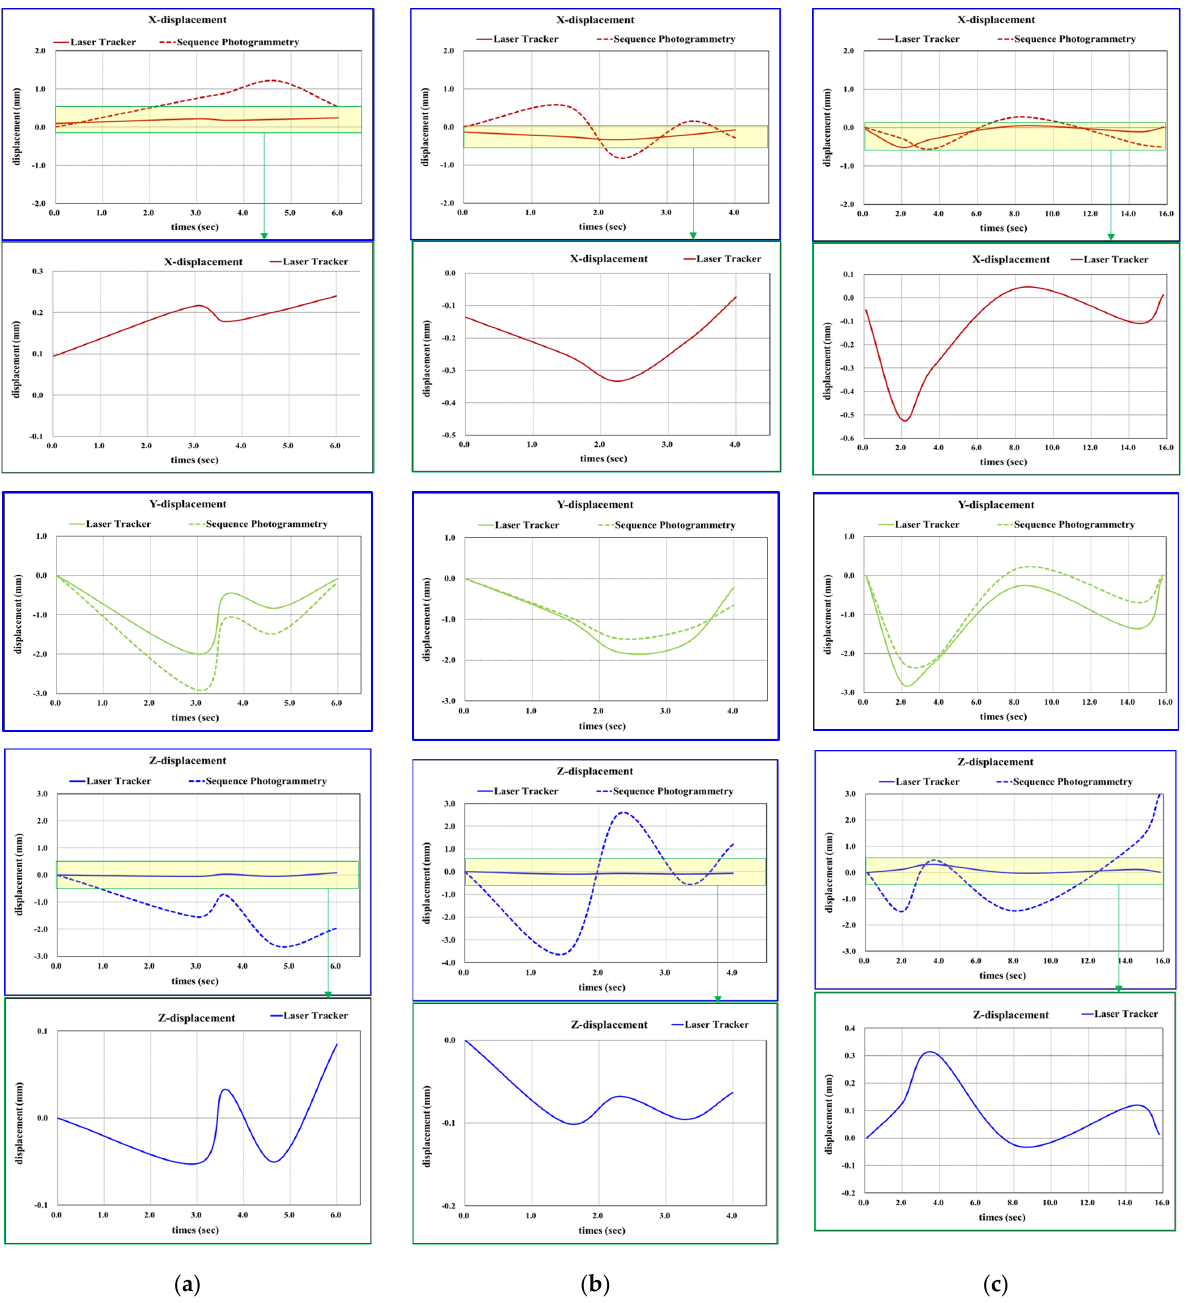
Figure 9. Enlarged deformation curve in the 3D axes’ directions. ( a ) First train; ( b ) second train; ( c ) third train.